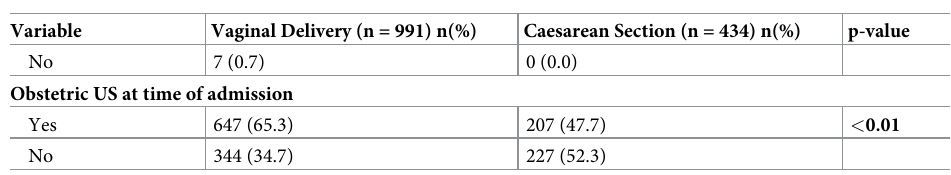
with pelvic abscess (Table 2). Maternal HIV status. There were 168 (11%) HIV sero-positive participants in this study. HIV sero-status did not have a statistically significant impact on maternal or fetal outcome (p = 0.68) even at multivariate analysis.